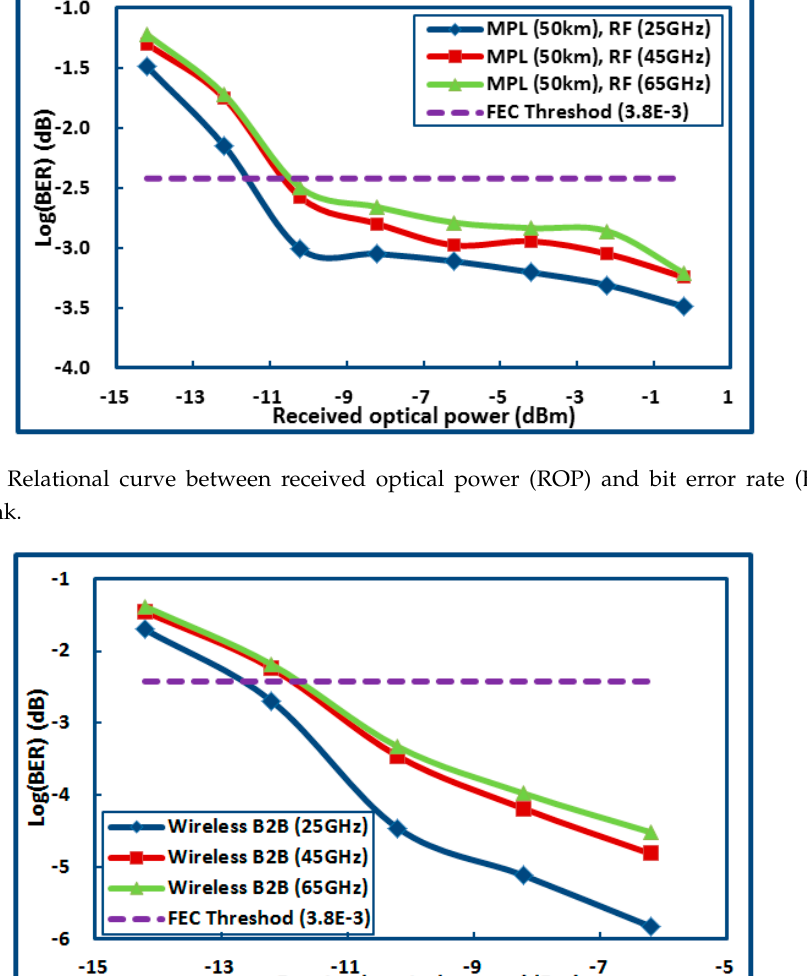
Figure 17. Relational curve between ROP and BER in the wireless link.